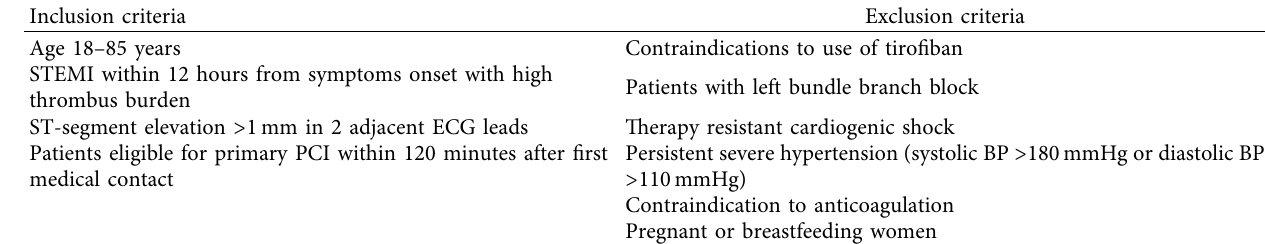
Table 1: Inclusion and exclusion criteria